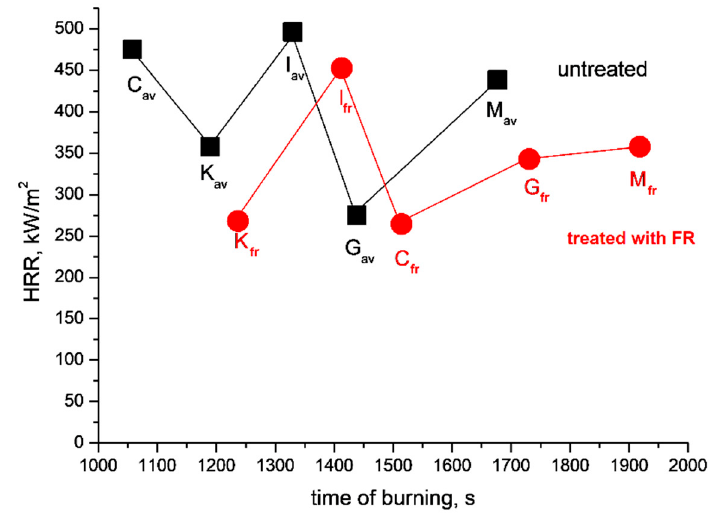
Figure 8. Changes of HRR with time of burning for tropical woods untreated and treated by FR (red line).